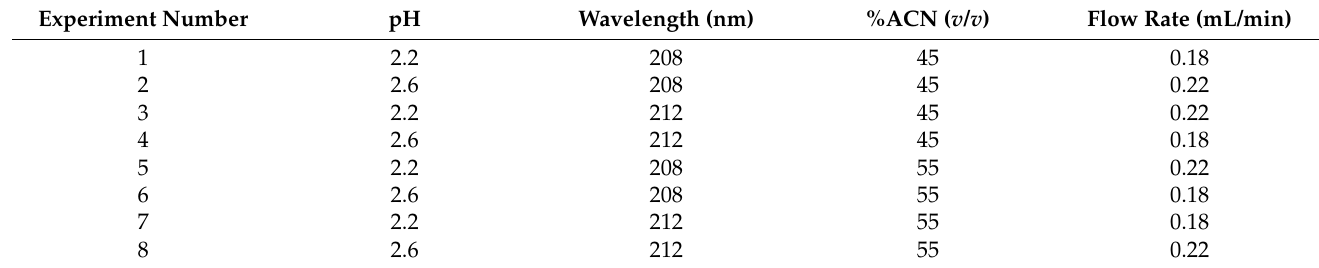
Table 8. The total of eight experiments proposed by the software for FFD.